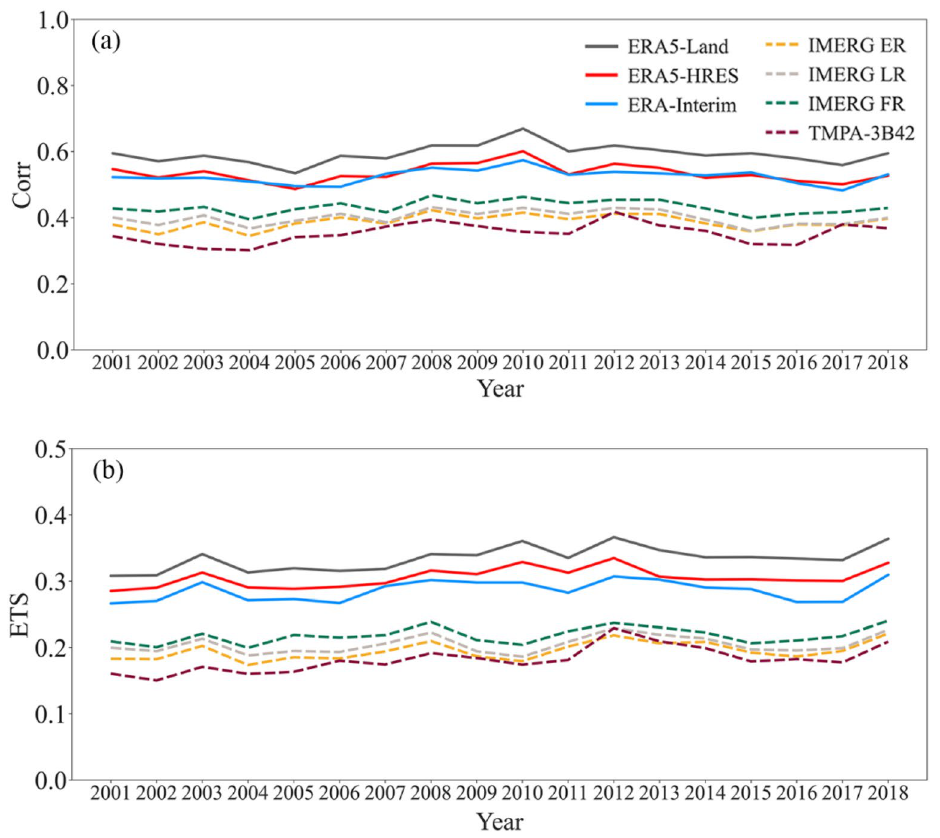
Figure 8. Annual ( a ) Corr and ( b ) ETS for different precipitation products from 2001 to 2018.